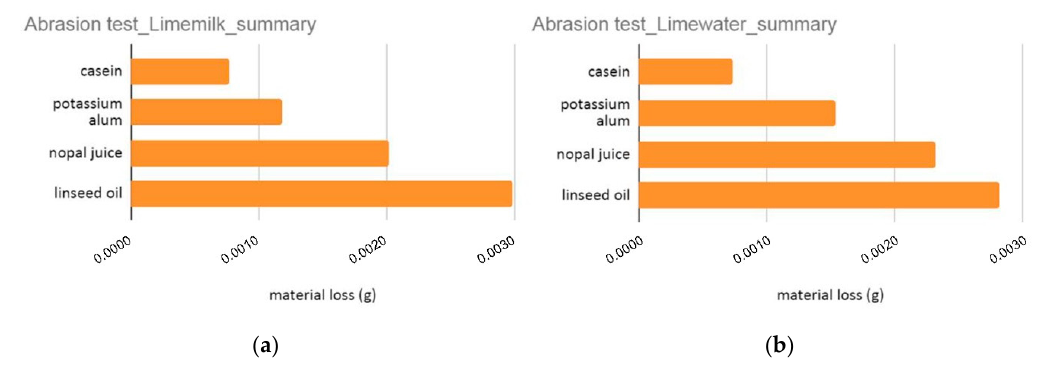
Figure 19. Summary of results for abrasion test for ( a ) Limemilk and ( b ) Limewater with four natural stabilizers.